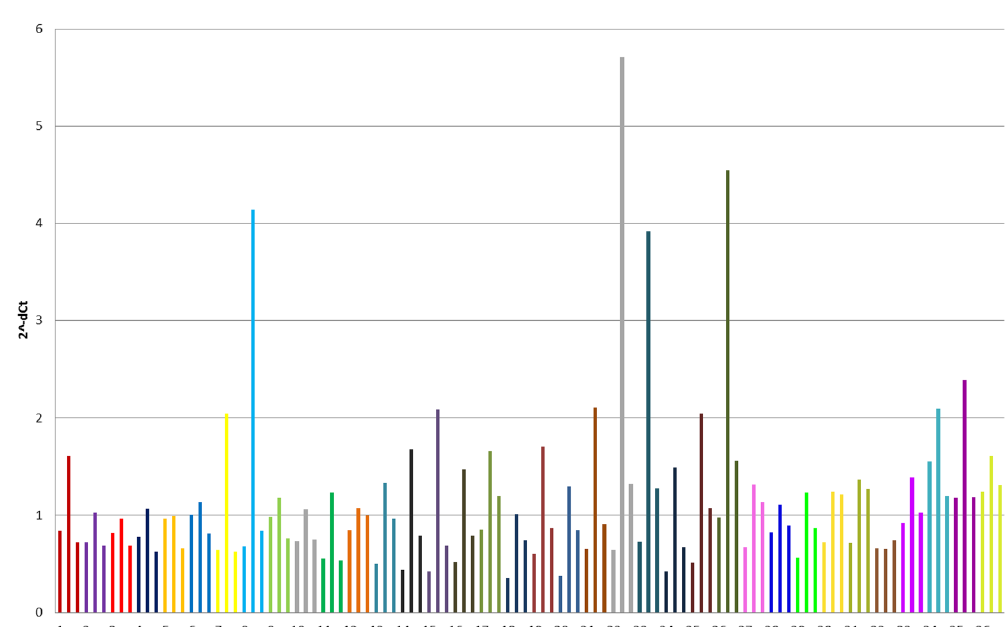
Figure 3. Differences in relative T/S ratios among whole blood, plasma and serum samples in 36 healthy young volunteers. Individuals are marked by different colours. The order of samples for each individual is following: whole blood, plasma and